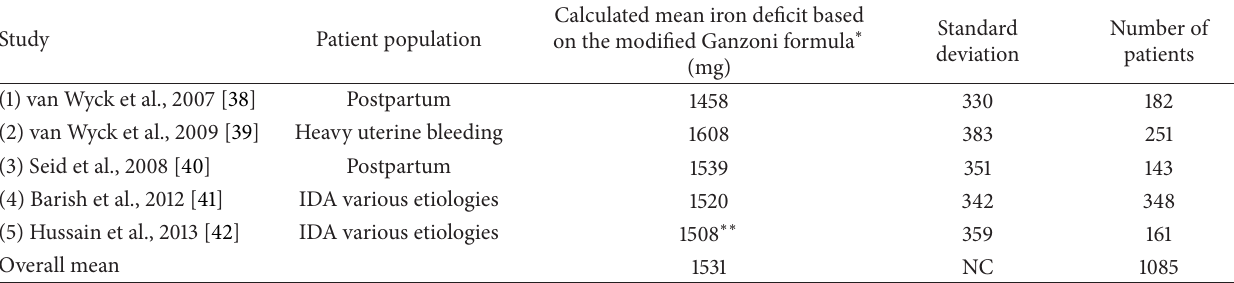
Table 3: Average calculated iron deficit dose in clinical Studies